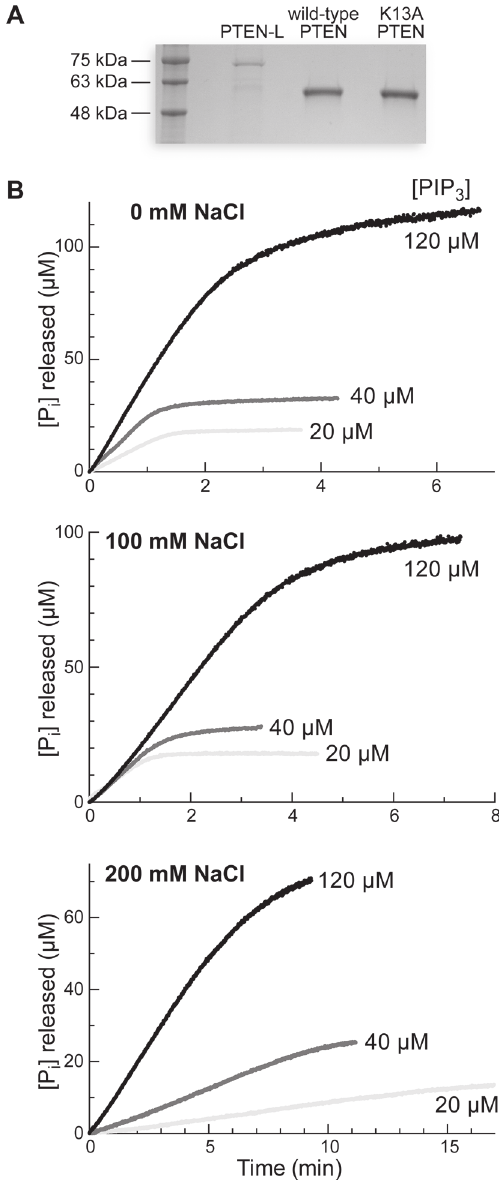
Figure 2. Initial characterization of PTEN. (A) Analysis of PTEN-L, wild-type PTEN, and K13A PTEN on a Coomassie R-250 – stained polyacrylamide (12% w/v) gel containing sodium dodecylsulfate (0.1% w/v). (B) Representative progress curves for the turnover of PIP 3 (10, 15, or 40 μ M) by wild-type PTEN. Reactions were performed in 50 mM Tris – HCl buffer, pH 7.6, containing EDTA (2.0 mM), MESG (0.20 mM), DTBA (40 mM), and NaCl (0, 100, or 200 mM), and were initiated with the addition of PTEN to 20 nM. Absorbance at 360 nM was converted to concentration by using Δ ε = 11 mM − 1 cm − 1 .